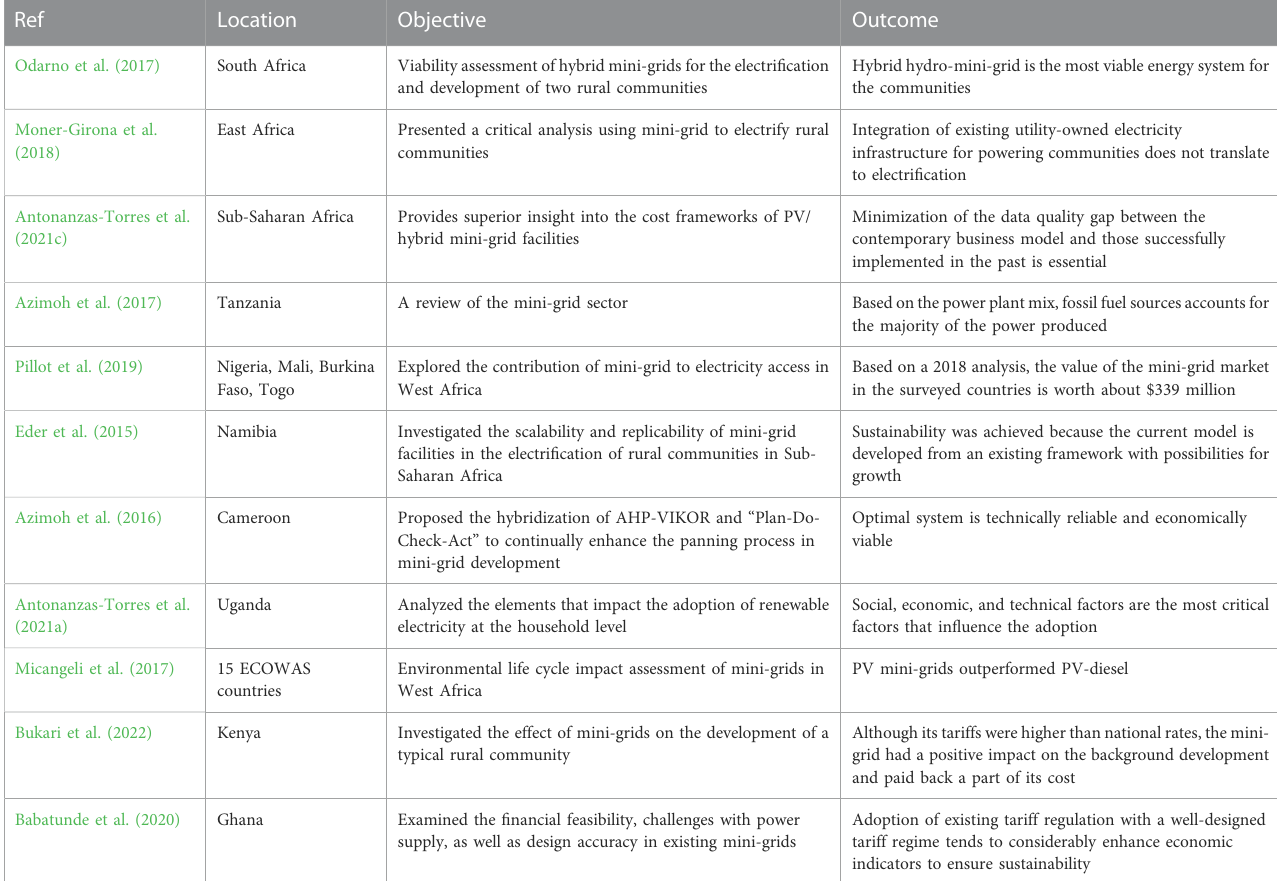
TABLE A1 Literature on the state of mini-grids in